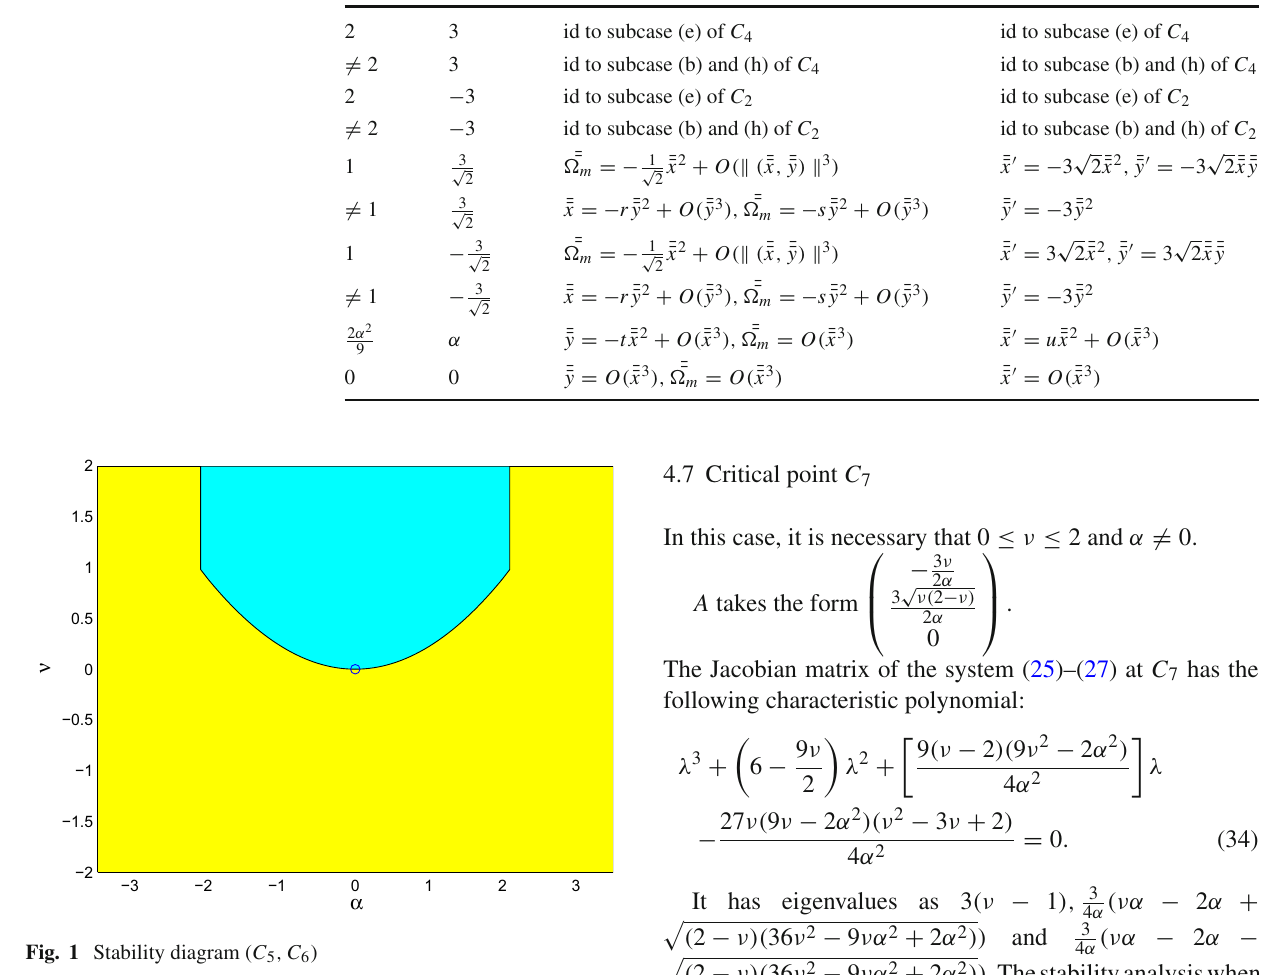
Table 12 C 6 (reduced system)